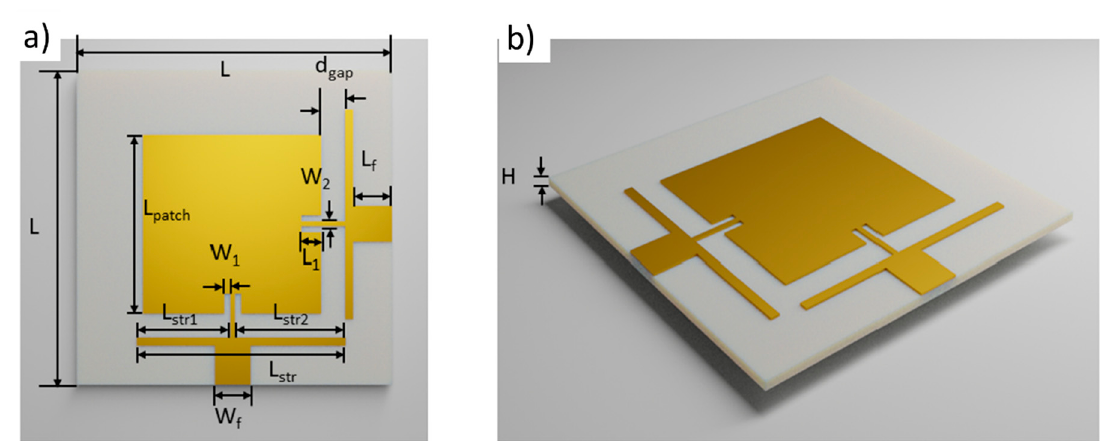
Figure 1. Geometrical parameters of the dual-port full-duplex textile-based patch antenna. ( a ) Top view. ( b ) Side view. Design dimensions: H = 2 mm, L = 80 mm, L patch = 45.8 mm, L str1 = 19.1 mm, L str2 = 25.5 mm, L str = 53.6 mm, L f = 6 mm, W f = 7 mm, L 1 = 4.5 mm, W 1 = 1 mm, W 2 = 0.8 mm, and d gap = 7 mm [23].